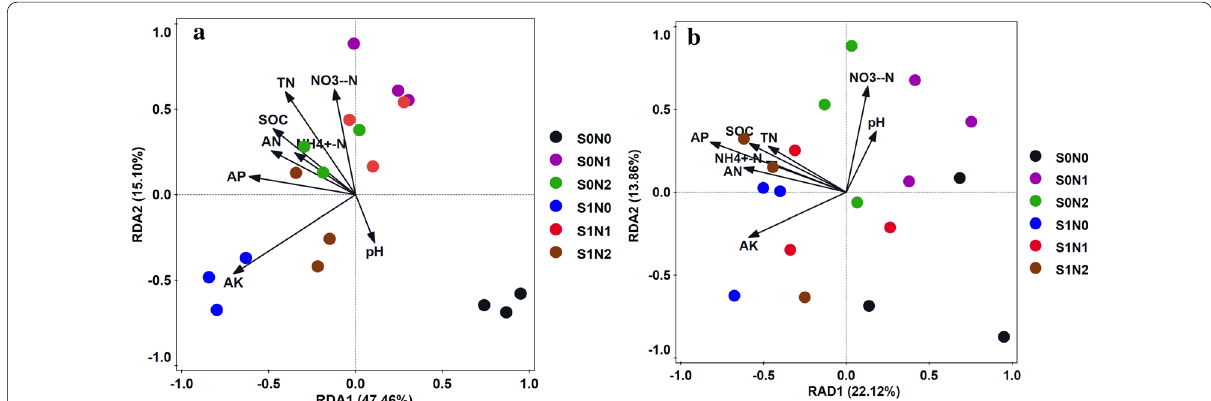
Fig.7 Redundancy analysis (RDA) of the correlation of soil properties with AOA community structure ( a ) and AOB community structure ( b ). S0N0: No straw mulching with no nitrogen, S0N1: No straw mulching with 120 kg N ha − 1 , S0N2: No straw mulching with 180 kg N ha − 1 , S1N0: Straw mulching with no nitrogen, S1N1: Straw mulching with 120 kg N ha − 1 , S1N2: Straw mulching with 180 kg N ha −